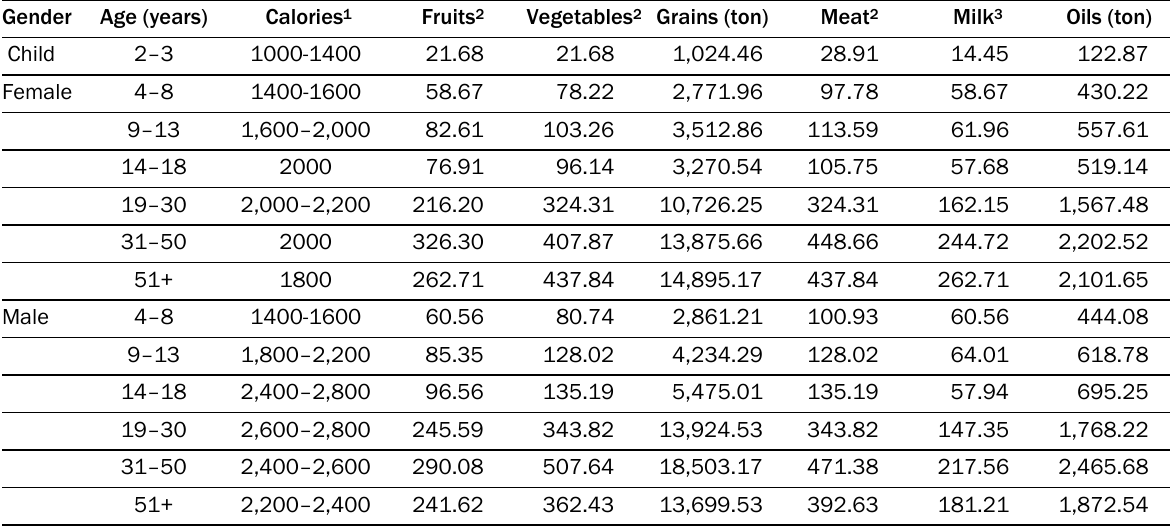
Table 3. Total Food Requirements of the Philadelphia Population by Age Group According to the DGA